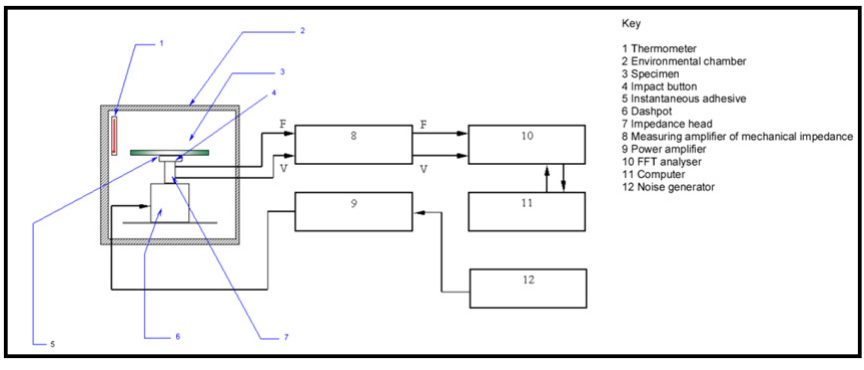
Fig. 9 Principle of the MIM